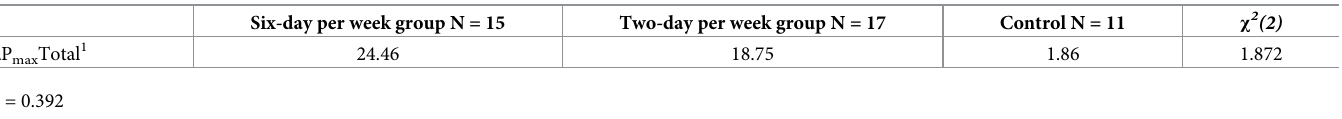
unhealthy food over time or between groups (Table 3). All variables were of normal distribu- tion with the exception of changes in P Total (Shapiro-Wilk P < 0.05, Skewness: 1.24, max SE = 0.37; Kurtosis: 9.26, SE = 0.72; histogram included in supplementary data). Thus, a Krus- kal-Wallis Test was used to confirm no difference between groups for changes in P Total max (Table 4). Spearmen correlation analysis indicated that P Total negatively correlated with max changes in FFM (P = 0.03), with no correlations between changes in FM, REE, hunger or exer- cise parameters (weekly energy expenditure, exercise group). Positive correlations (both when assessed via Pearson or Spearmen) were observed between FM change, exercise energy expen- diture per week, and exercise group (all P < 0.1). Pearson correlations demonstrated a positive correlation between changes in REE and changes in hunger (P = 0.02). Quantile regression analysis predicting changes in P Total is presented in Table 5, demonstrating changes in max FFM to be the only significant predictor for changes in P Total when controlling for weekly max Table 4. Kruskal Wallis Test for changes total food reinforcement ( Δ P max Total, non-normally distributed) between groups that exercised either six or two days per week and a sedentary control group. Data are mean